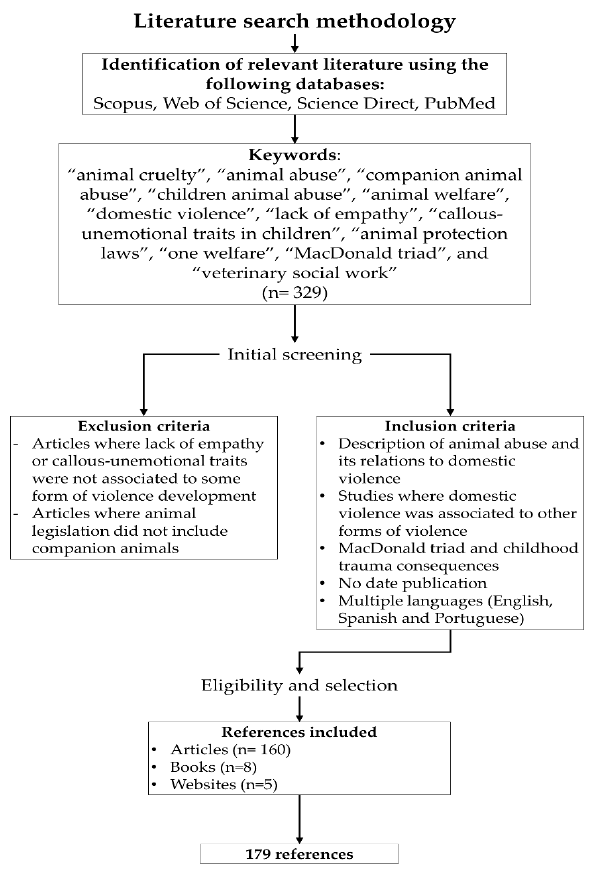
Figure 1. Search methodology.